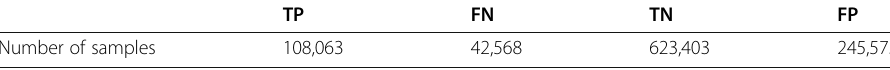
Table 7 Number of TP, FP, FN, and TN in test data set TP FN TN FP Number of samples